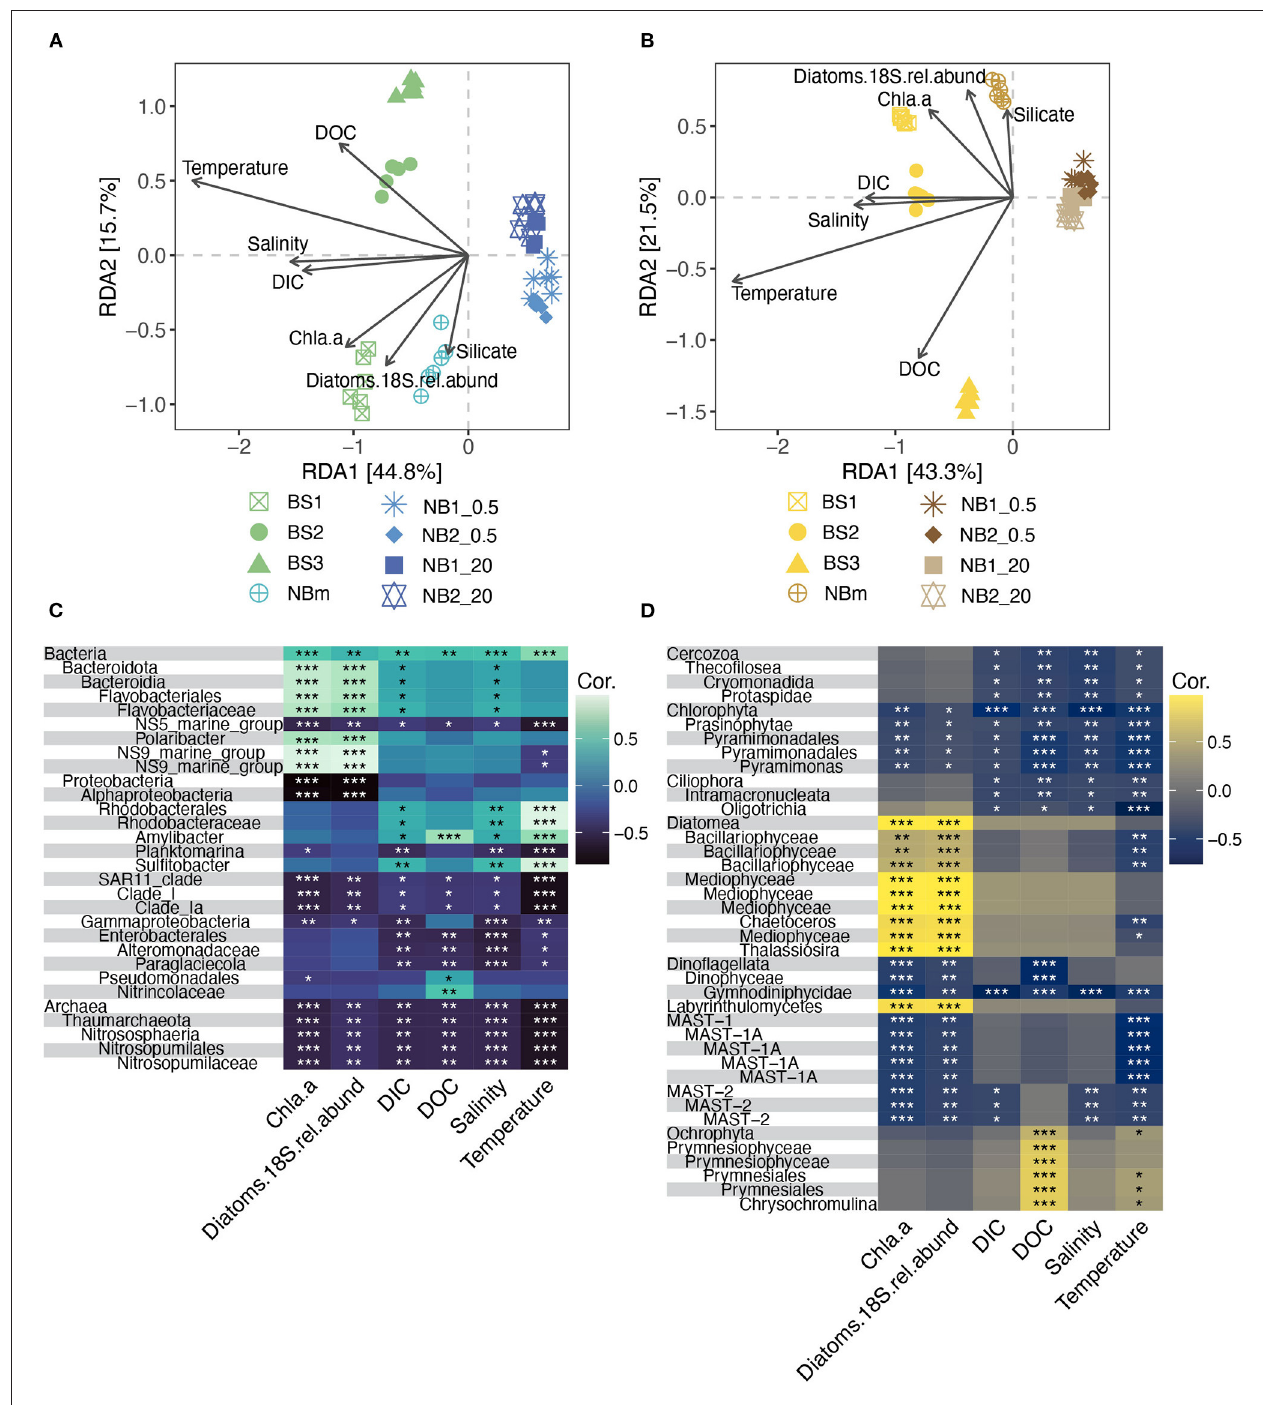
FIGURE 5 | Beta diversity and the contextual environmental measurements showed similar patterns of differences for both prokaryotic and microeukaryotic communities compared between all sampling stations. Distance-based Redundancy analysis (dbRDA) biplot of prokaryotic (A) and microeukaryotic (B) beta diversity measured as unweighted UniFrac distances (sample scores) and environmental factors as arrows pointing to the direction of maximum variation of the respective factor. Heatmaps showing Pearson’s correlation between environmental factors and differentially represented prokaryotic (C) and microeukaryotic (D) taxa were obtained from the LEfSe analysis. The color indicates Pearson’s correlation coefficient according to the color legend and the level of significance is marked with * (*, p ≤ 0.05; **, p ≤ 0.01; ***, p ≤ 0.001).